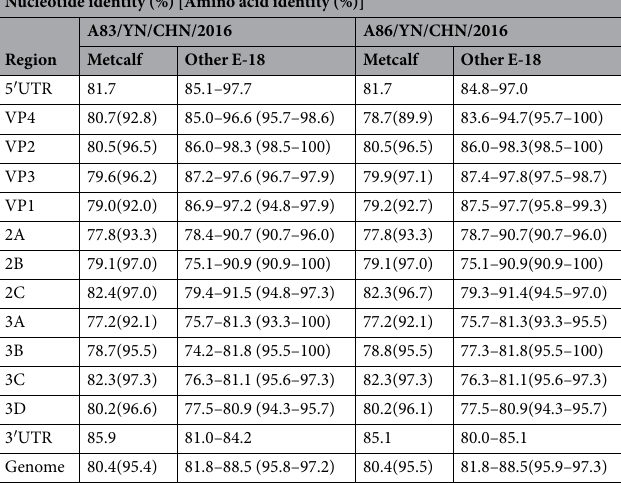
Table 1. Nucleotide and amino acid identities between the two Yunnan E-18 strains, Metcalf and other E-18 in all sequenced genomic